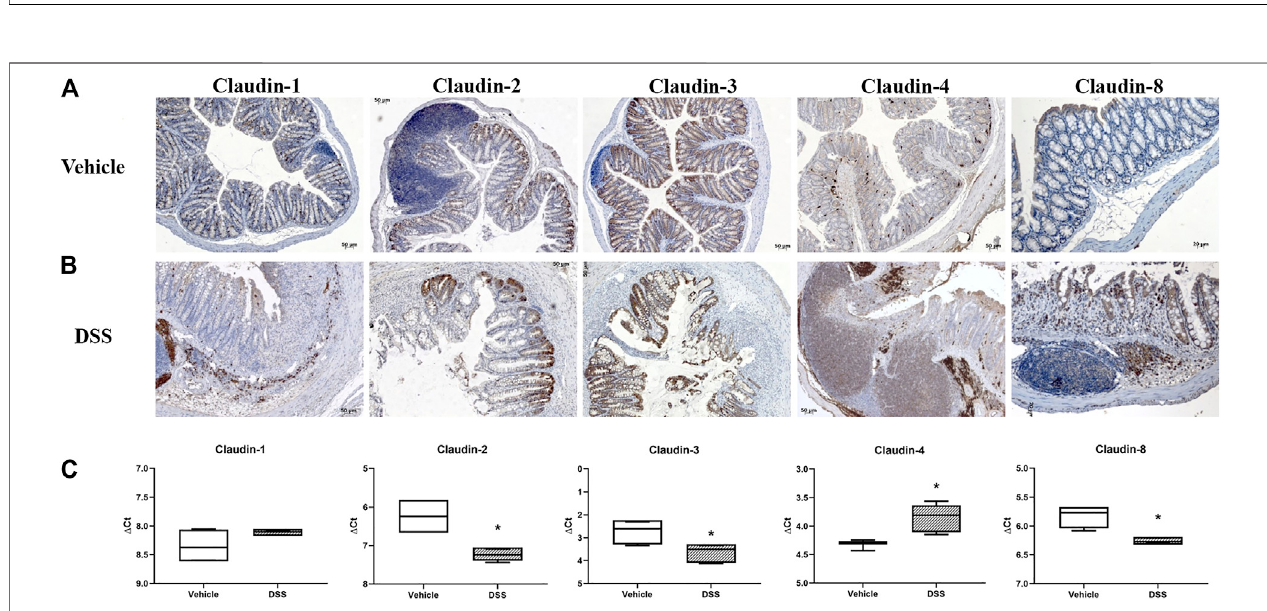
FIGURE9| Claudin-1,claudin-2,andclaudin-3expressionbygranulomacellsincolonofCDpatients. (A) Claudin-1(IHC),CD; (B) claudin-2(IHC),CD; (C) claudin- 3 (IHC), CD. CD, Crohn disease.